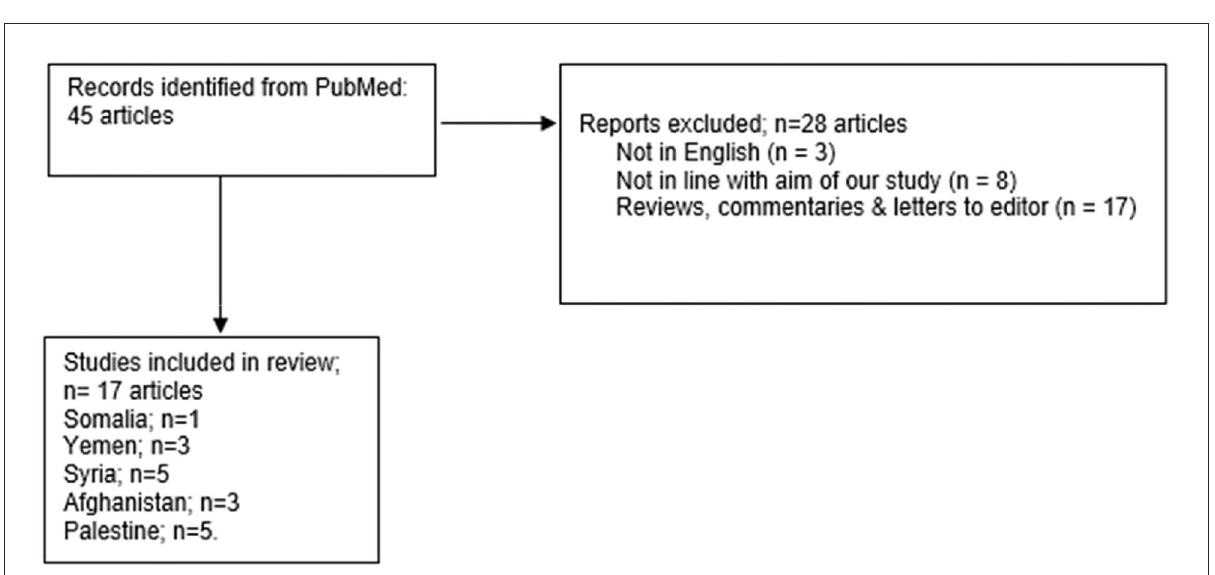
FIGURE1 Flowchart displaying the screening process for the included studies in the